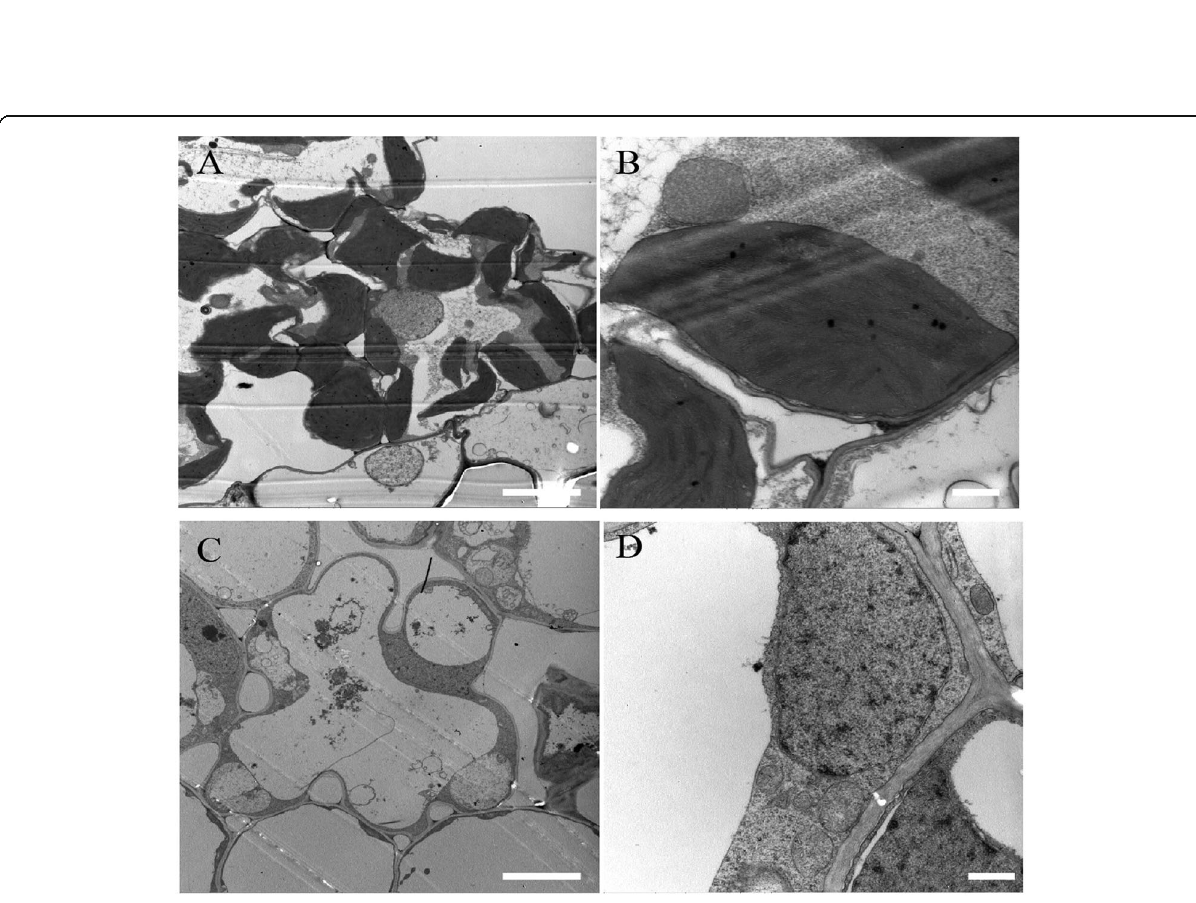
Fig. 2 TEM analysis of chloroplast ultrastructure in wild type and the las1 mutant. a - b Chloroplast structure in WT cell. c - d Chloroplast structure in las1 cell. Scale bars 1 μ m for ( b ) and ( d ); 5 μ m for ( a ) and ( c